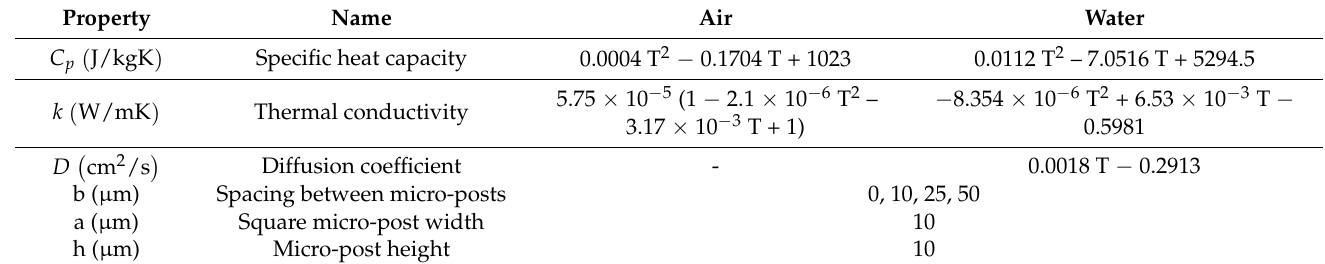
Figure 4. Grid independence solution along with vertical height (X ‐ X’) for: ( a ) velocity magnitude and ( b ) pressure variation (gage pressure) at 0.054 s. Droplet volume is 10 μ L droplet and impact height is 20 mm.